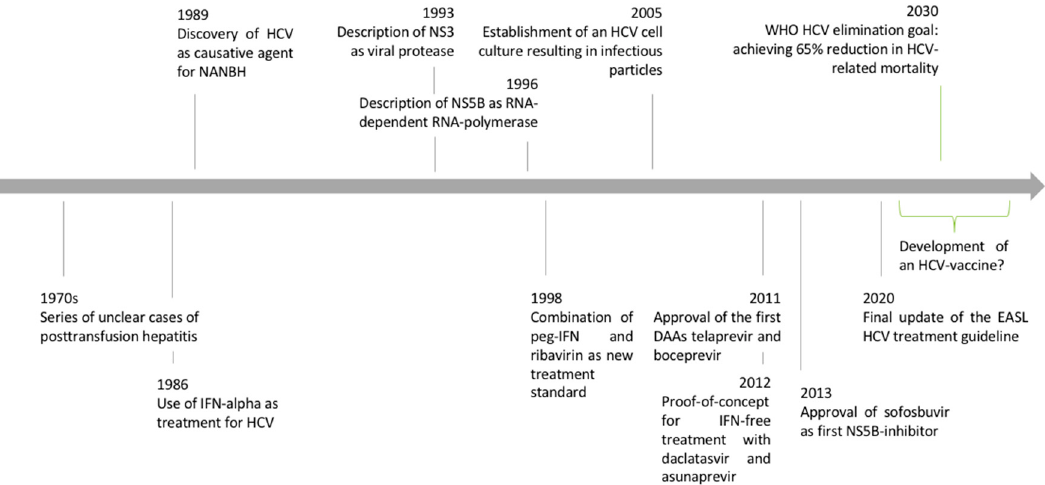
Figure 1. Timeline of HCV discovery and advances in clinical and basic virologic research. Adapted from [2].